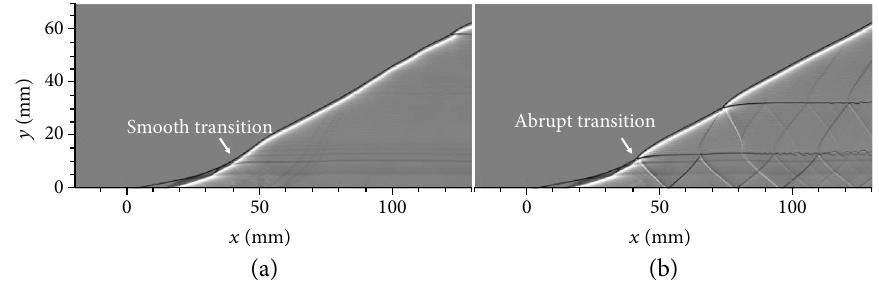
Figure 7: Steady fl ow fi elds before and after UTHD at θ = 31 ∘ . (a) Before and (b) after.